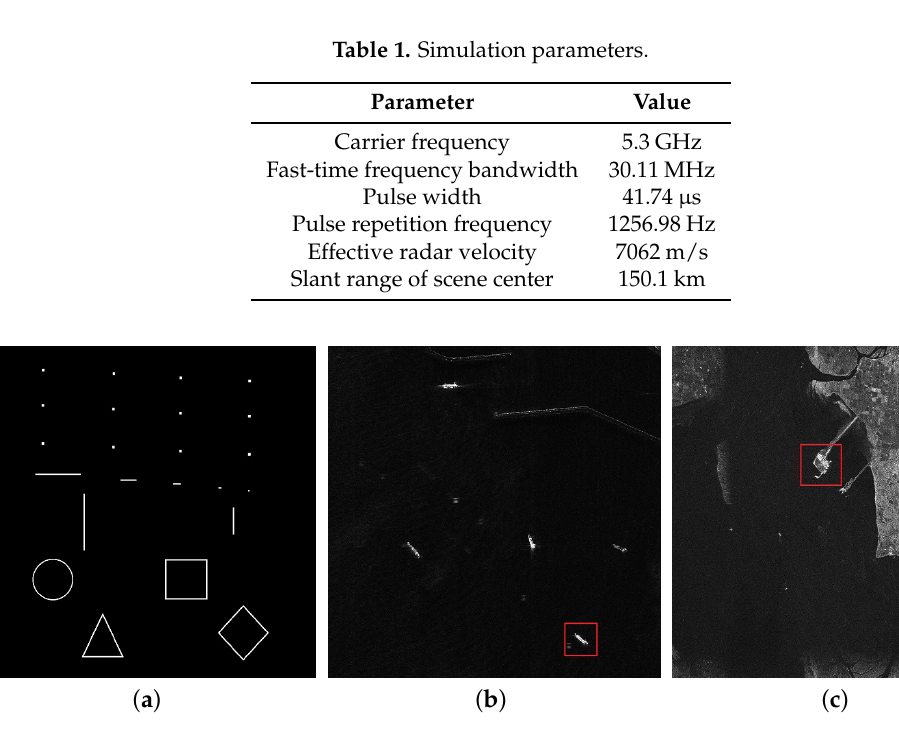
Figure 4. Scenes of interest in simulations. ( a ) a synthetic image; ( b ) a real SAR SLC image, collected by TerraSAR-X on 1 May 2008, and the imaged area is near the coast of Barcelona; ( c ) an SLC image focused from RADARSAT-1 raw data and the red-framed area is the Tsawwassen Ferry